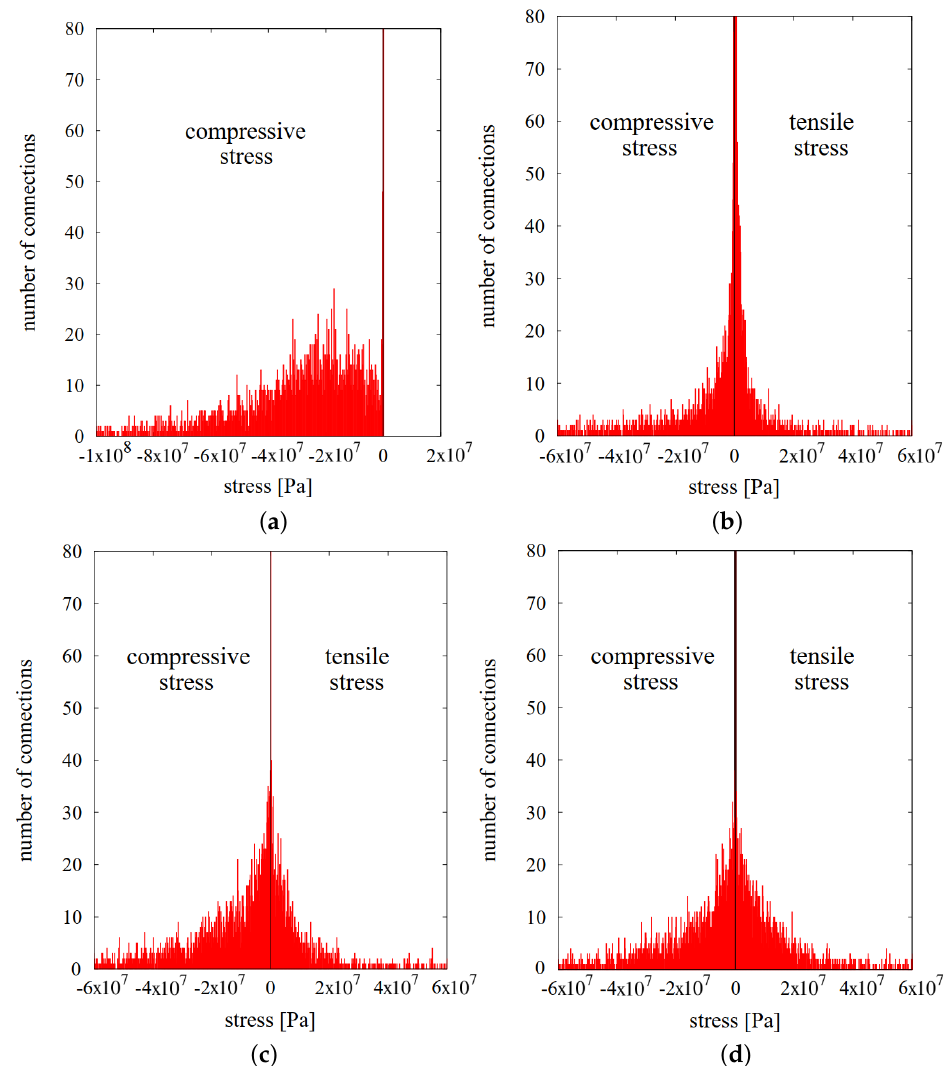
Figure 14. Distribution of particle total hydrostatic stresses: ( a ) after loading, before heating (t = 33 min); ( b ) in the final stage of sintering (t = 155 min, t s = 30 min); ( c ) after cooling, before unloading (t = 293 min); and ( d ) after